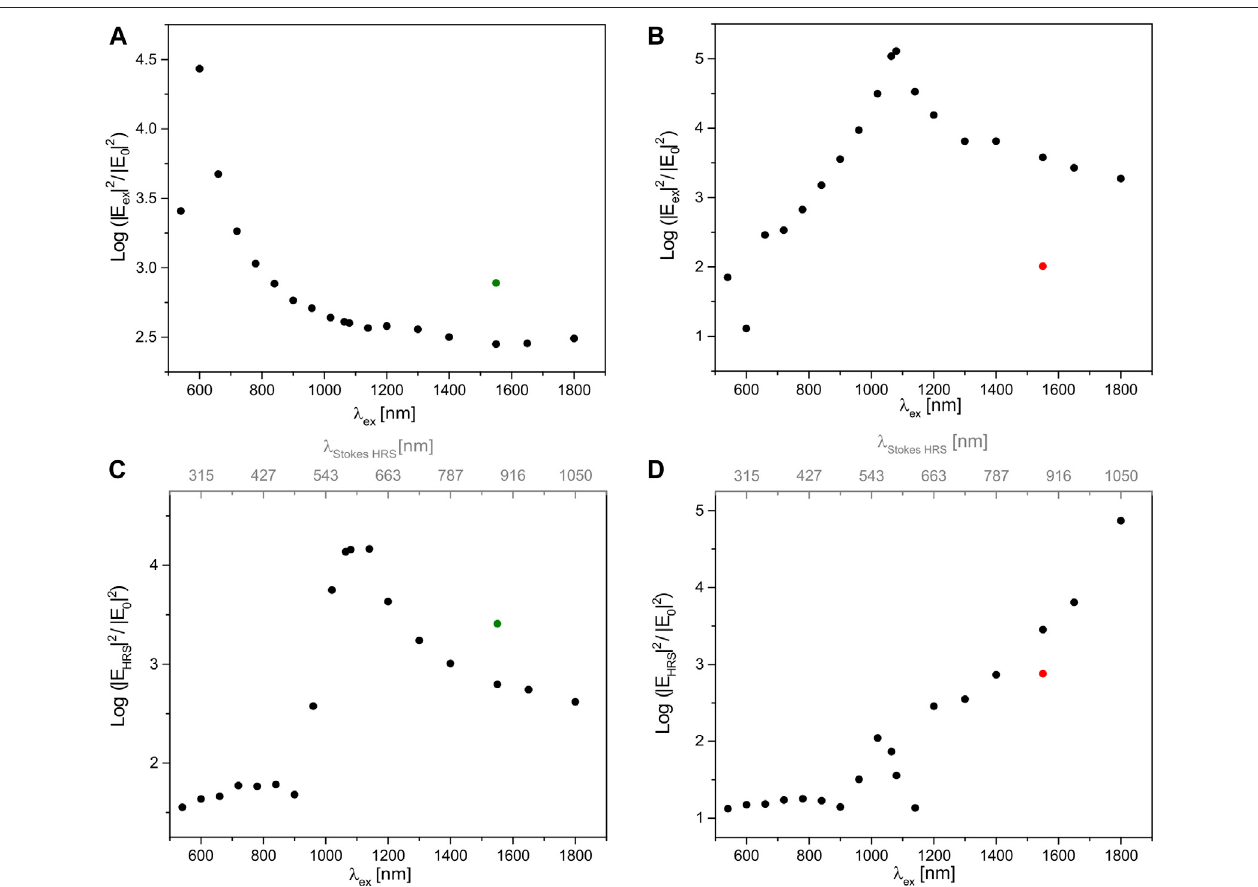
FIGURE 2 | Maximum intensity enhancement of (A,B) the normalized excitation fi eld and (C,D) the normalized fi eld of the hyper Raman scattering as a function of excitationwavelengthprovidedbyadimer (A,C) ofgoldnanospheresofadiameterof44 nmand (B,D) ofgoldnanorodswithalengthof80 nmandathicknessof16 nm as a result of 3D FDTD simulations. Values on the top axes in (C) and (D) represents the Stokes HRS wavelengths corresponding to a molecular vibration with a wavenumber of 1,586 cm − 1 for the excitation wavelength indicated on the; bottom axis. The gap between the particles is 2 nm. The propagation of the incident plane wave is in z-direction, and it is polarized along the long axis of the dimers (cf. Figure 3 or Figure 4 ). The green dots in (A) and (C) indicate the intensity enhancementsofadimerofgoldnanosphereswithadiameterof70 nm,correspondingtothegeometryofnanospheresintheexperimentsreportedinref.(Heineretal., 2021). The red dots in (B) and (D) indicate the maximum intensity enhancements attained by of a single gold nanorod of the same